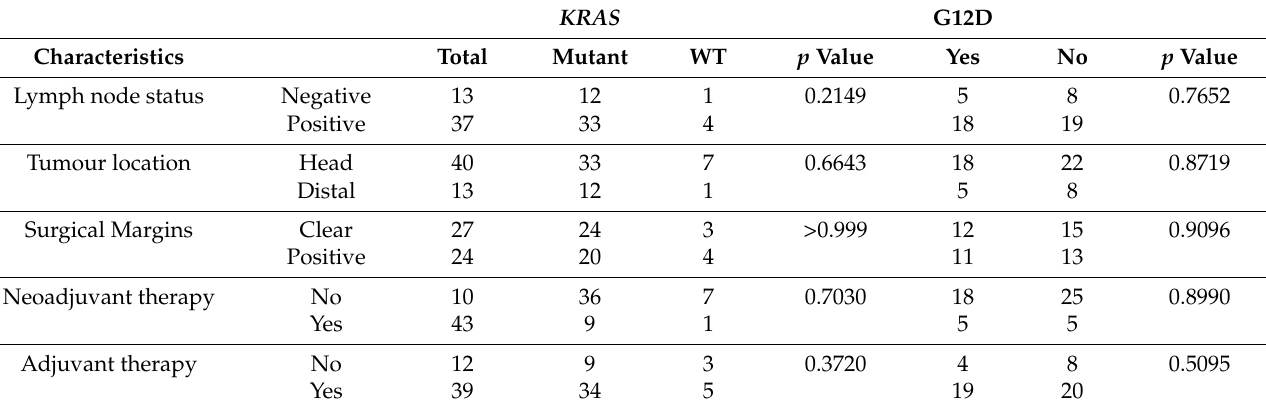
Table 3: Surgical characteristics in patients who received surgery. Lymph node status, tumour location within pancreas, neoadjuvant therapy, resection margin and adjuvant therapy information was present for 50, 53, 51, 53 and 51 patients, respectively, due to loss of follow-up. Correlation assessed using chi-square test with Yates’ continuity correction and Fisher’s exact test. WT, wild-type; endoscopic ultrasound fine needle aspirate; NCCN, National Comprehensive Cancer